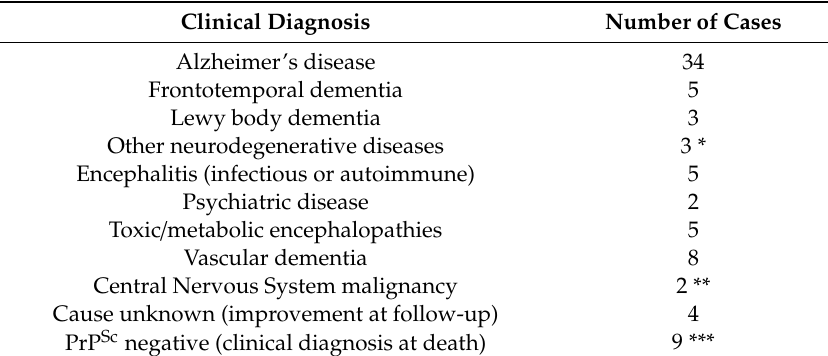
Table 2. Diagnostic categories